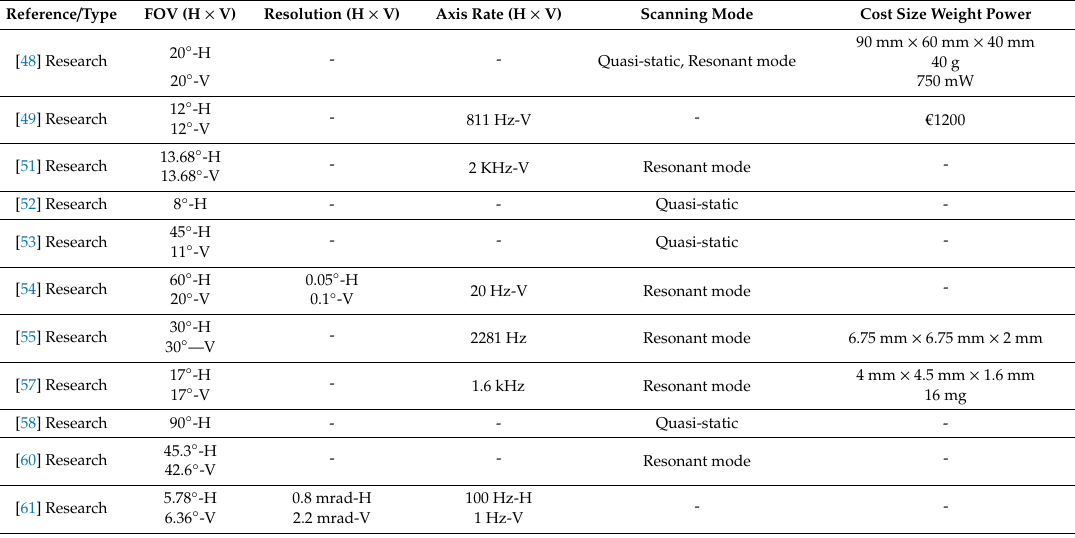
Table 3. Comparison of performance and SWaP specifications for selected MEMS scanning LiDAR. Reference /